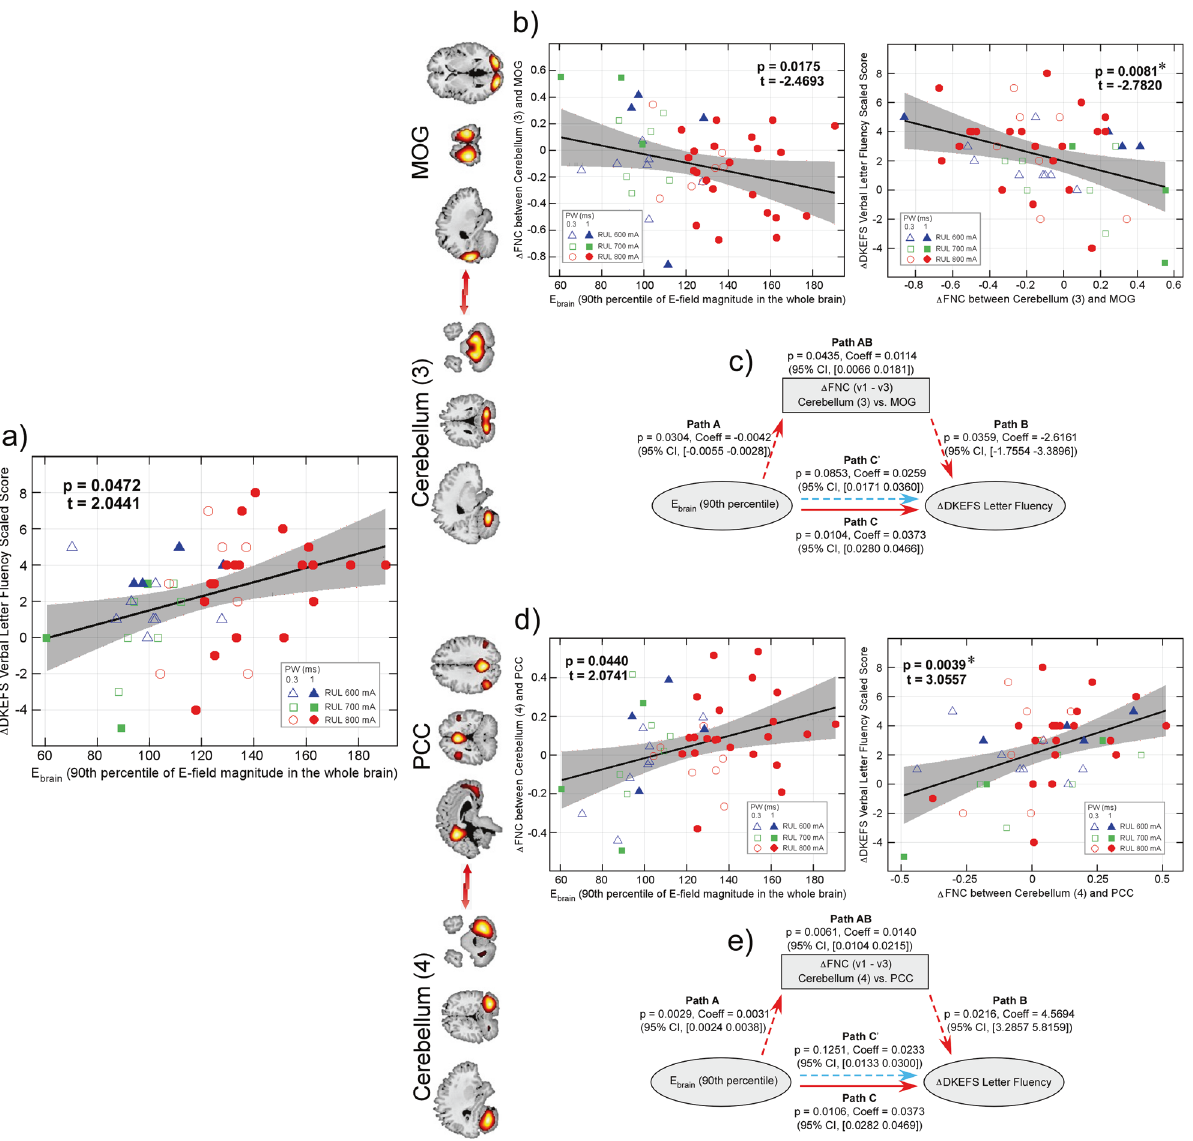
Fig. 3 E brain , FNC neuroplasticity and cognitive side-effects. a E brain is positively correlated with the change in DKEFS Verbal Fluency - Letter Fluency. b Changes in FNC between cerebellum (3) and MOG is negatively correlated with E brain and the change in DKEFS Verbal Fluency - Letter Fluency. c Δ cerebellum-MOG FNC mediates the effects of E brain on Δ DKEFS Verbal Fluency - Letter Fluency. d Changes in FNC between cerebellum (4) and PCC is positively correlated with E brain and the change in DKEFS Verbal Fluency - Letter Fluency. e Δ cerebellum-PCC FNC mediates the effects of E brain on Δ DKEFS Verbal Fluency - Letter Fluency. * Signi fi cance p < 0.05, FDR corrected. E brain the 90 th percentile of electric fi eld magnitude in the brain, FNC functional network connectivity, DKEFS Delis Kaplan Executive Function System, MOG middle occipital gyrus, PCC posterior cingulate cortex, FDR false discovery (SC), auditory (AUD), visual (VS), sensorimotor (SM), cognitive-control (CC), and default-mode (DM) domains. The spatial maps of ICNs from the cerebellar and cerebral domains are displayed in Fig. 2a, b, respectively. Details of the ICN coordinates and labels are provided in the supplementary materials.